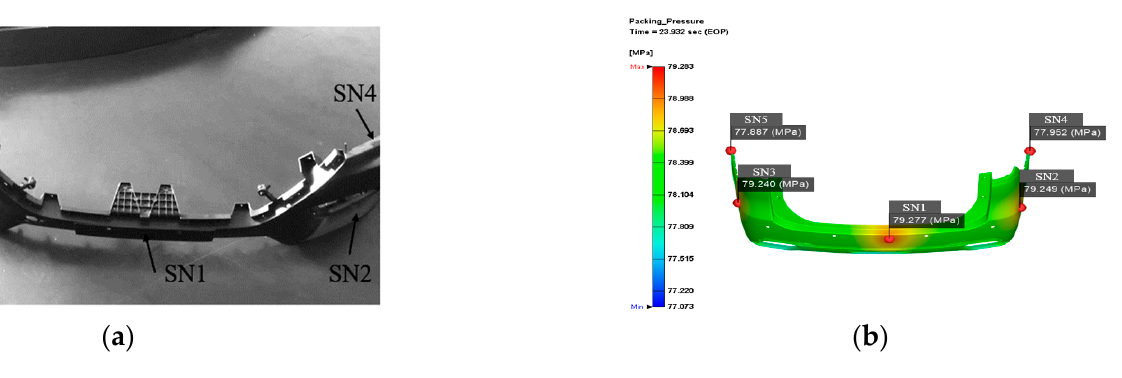
Figure 10. ( a ) Position of the pressure sensor in the cavity. ( b ) The pressure value captured by the sensor when the holding pressure was set to 80 MPa.